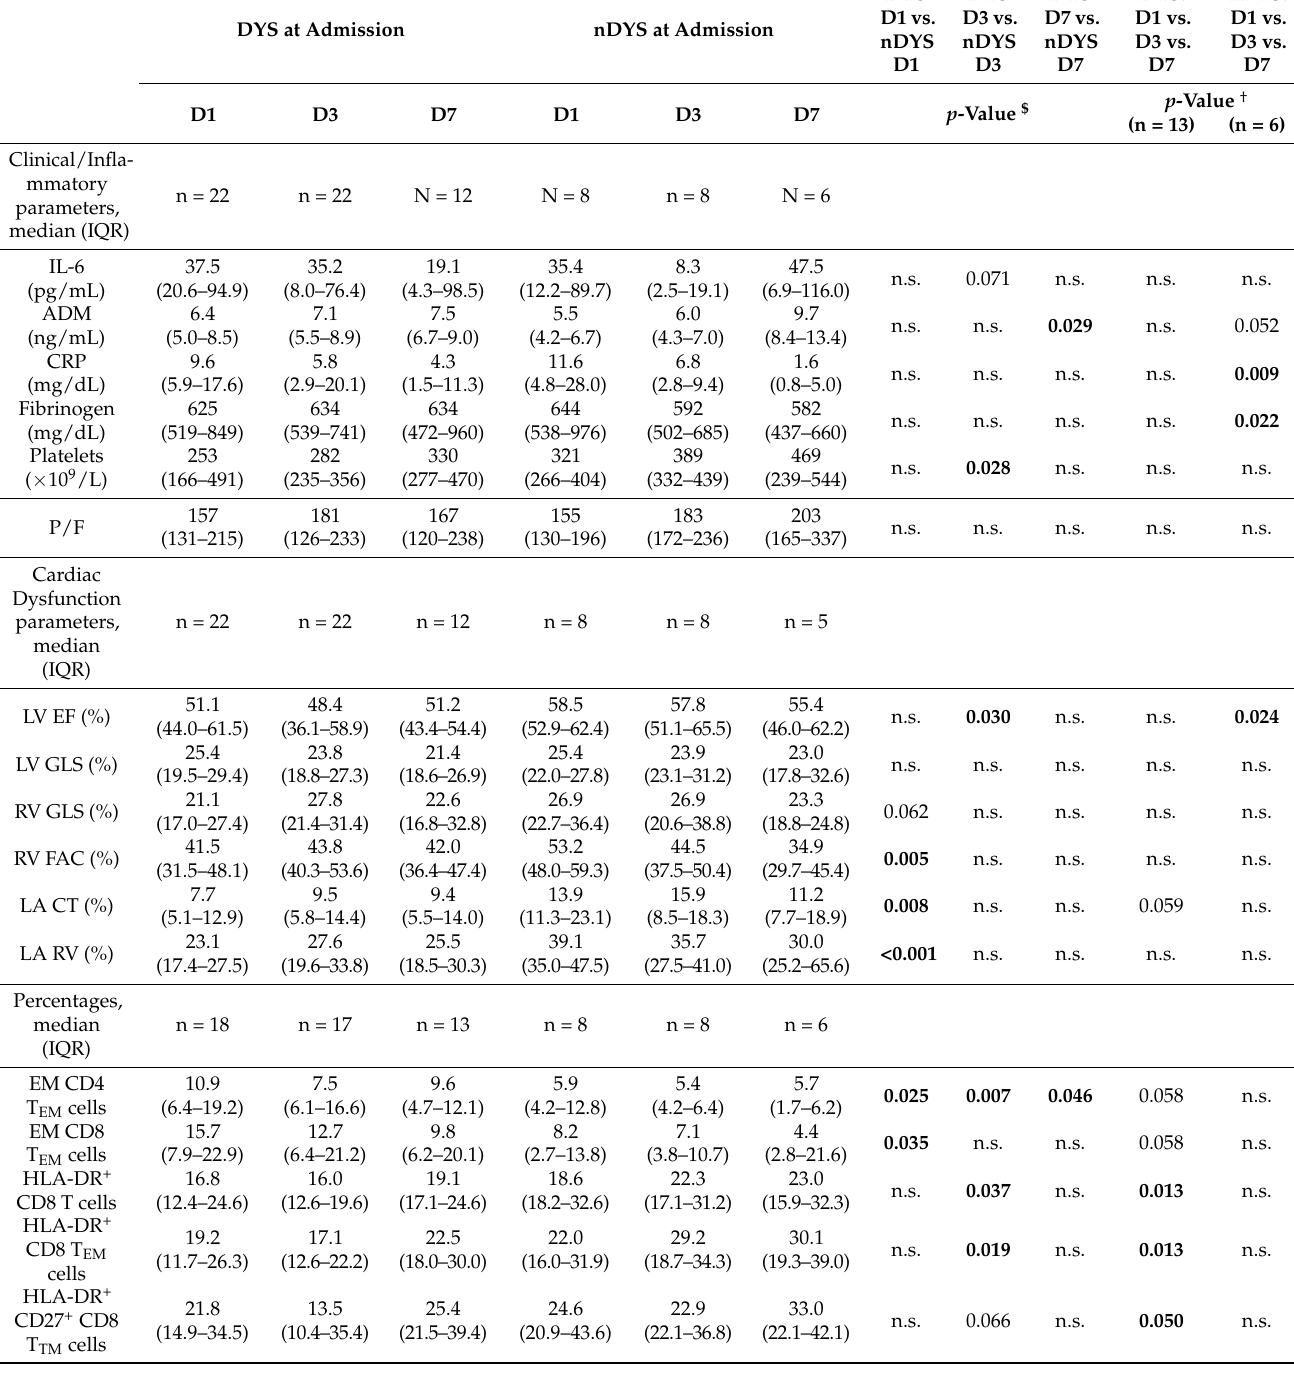
Table A1. Longitudinal dynamics of inflammatory, cardiac, and celular parameters in DYS and nDYS